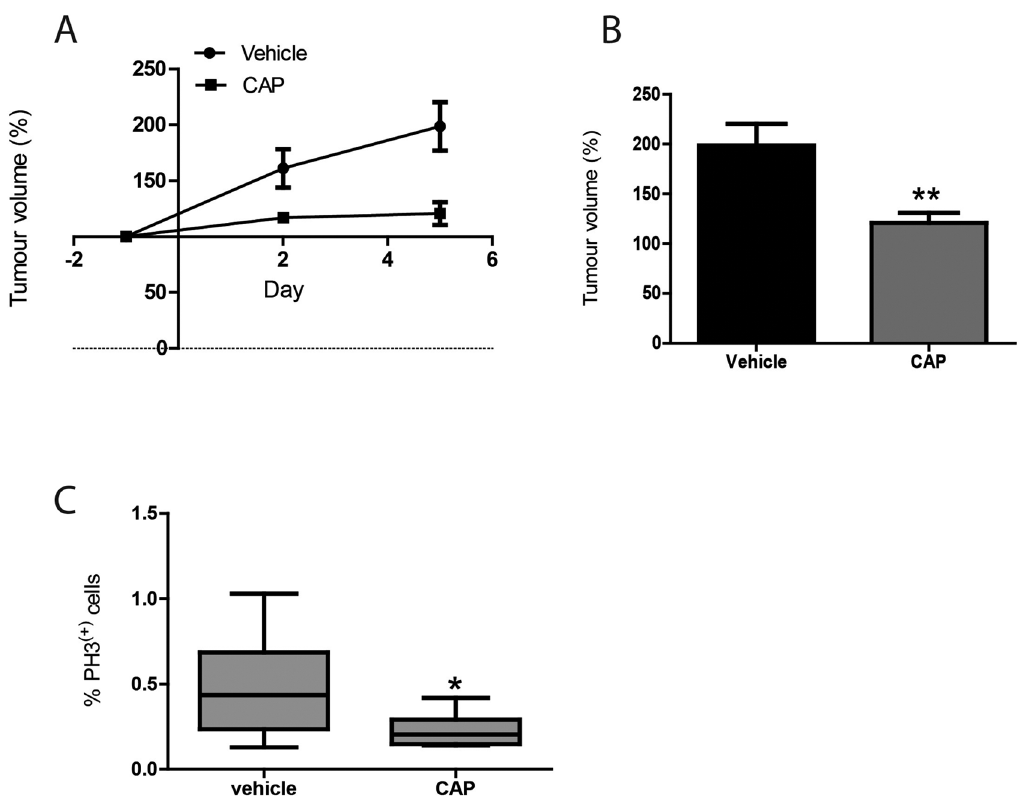
Figure 3 . Anti-tumour effect of capecitabine in insitu PDAC tumours. (A) Short term capecitabine efficacy study in KPC mice with in situ PDAC, dosed with 755 mg/kg for 7 consecutive days. Tumour volumes for vehicle and CAP were measured by ultrasound and normalized to the tumour volume at the day of the enrolment in study (mean 6 SEM, n=6 per group). (B) Tumour volume at the endpoint as a percentage of the volume at the start, in KPC mice treated with vehicle or CAP (mean 6 SEM, n=6 in each group; **p , 0.01). (C) Immunohistochemistry for phospho- histone H3 was quantified in PDAC tumours 2 h after the 7 th and last dose of CAP 755 mg/kg. Results are expressed as the mean 6 SEM (n=6 per group; *p=0.027).